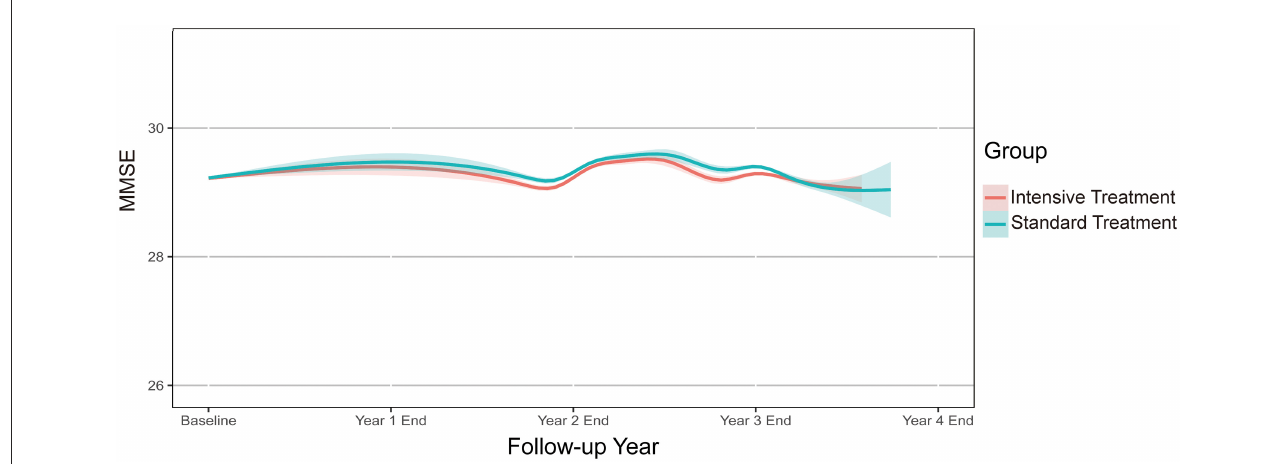
FIGURE2 Annual change in MMSE score during follow-up. Solid lines denote estimated mean MMSE for each treatment group based on a robust linear mixed model. Shaded regions indicate 95% confidence intervals. MMSE, Mini-Mental State Examination.